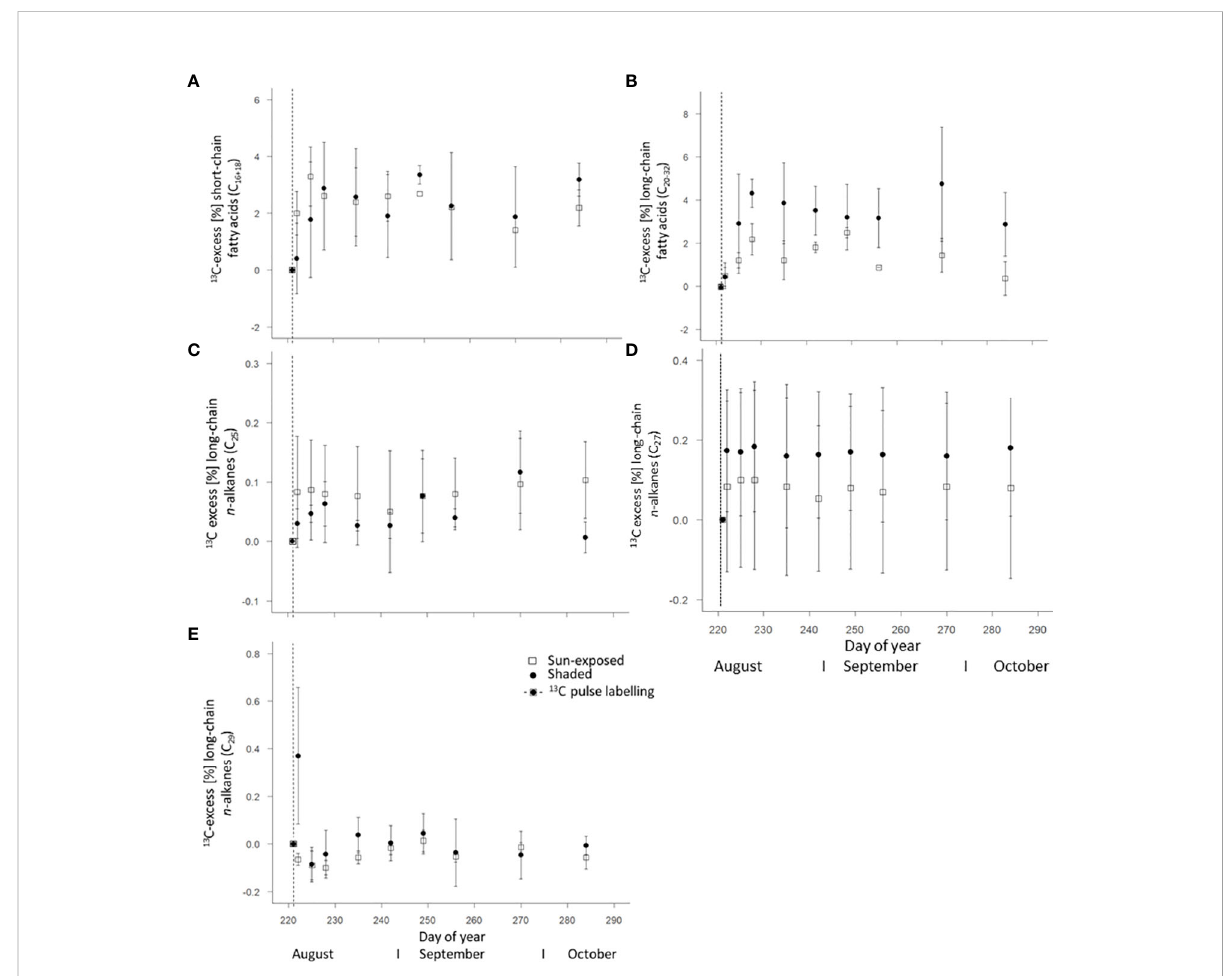
FIGURE 7 Weighted average of 13 C-excess of short-chain fatty acids C 16-18 (A) , long-chain fatty acids C 20:0-32:0 (B) of intracuticular waxes as well as n - alkanes C 25 (C) , C 27 (D) , and C 29 (E) of the cuticular waxes of sun-exposed and shaded leaves (analytical replicates n=3, error bars indicate SE). The vertical line in the graphs indicates the application date of the isotope